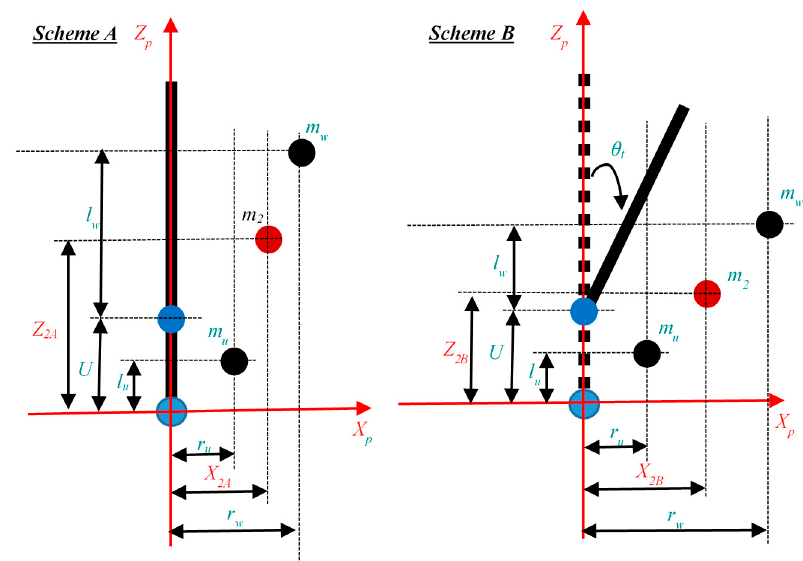
Figure 2. Two examples of balance configurations; scheme A and scheme B. m 2 is the total CoM. m u and m w are the CoMs of the two links.